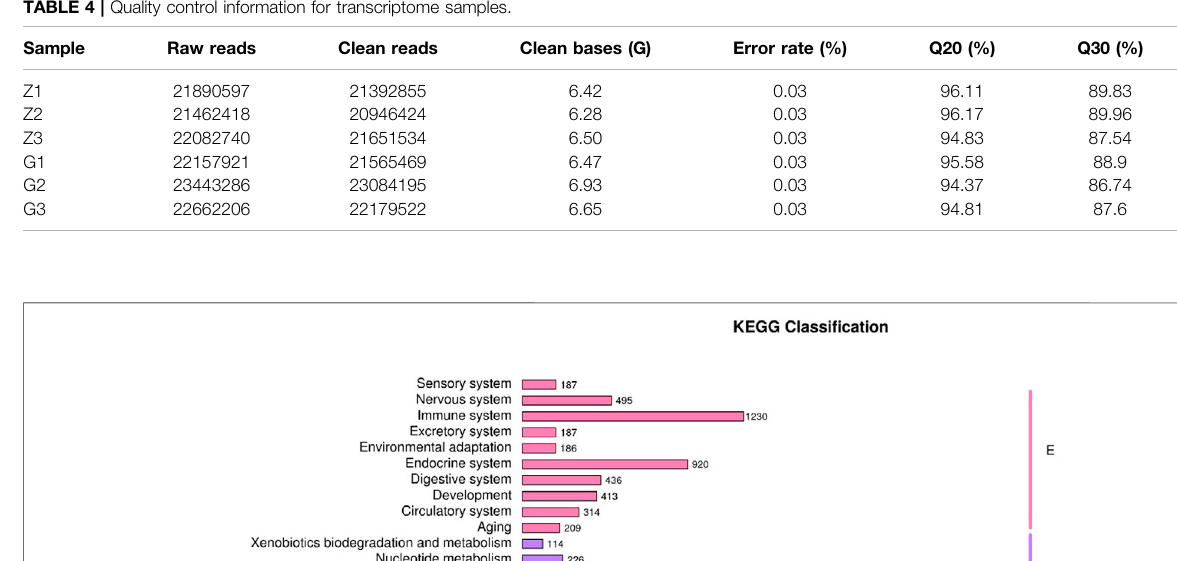
Frontiers in Physiology |